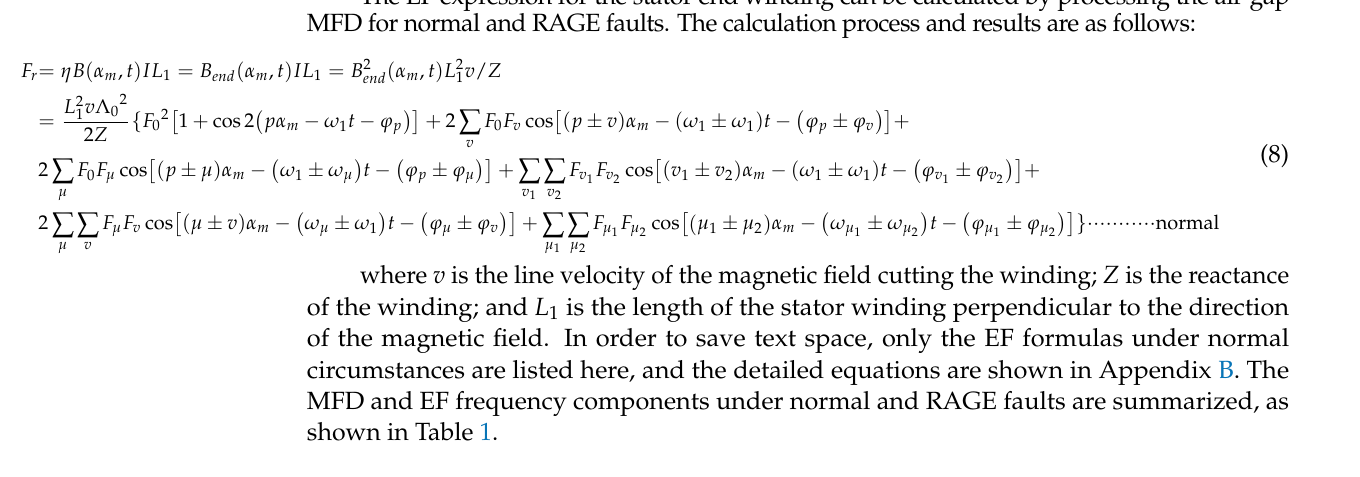
Table 1. Frequency components before and after RAGE fault.